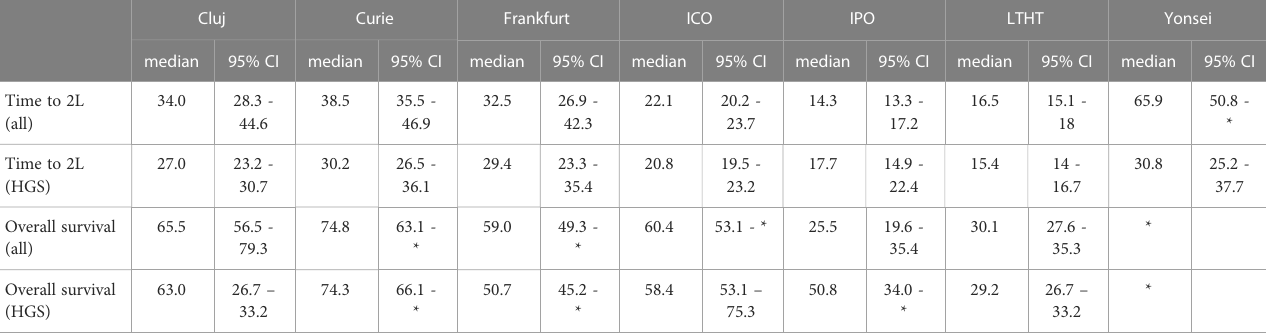
TABLE 4 Kaplan Meier estimates (in months) of time from diagnosis to the initiation of 2L SACT treatment ( ‘ Time to 2L ’ ) and of overall survival, by study site and showing estimates for whole cohort and patients with high-grade serous disease ( ‘ HGS ’ ). Cluj Curie